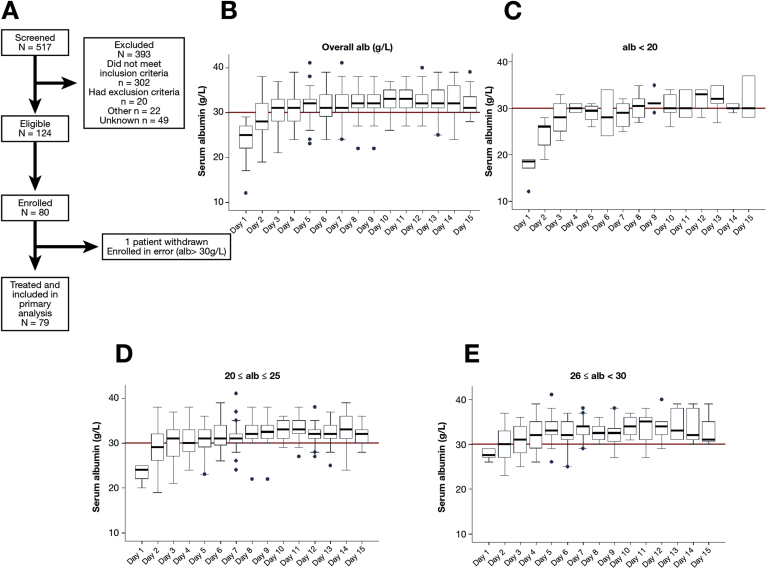
Targeted 20% HAS infusions according to the Albumin To PrevenT Infection In Chronic LiveR FailurE protocol effectively increase serum albumin to 30 g/L or greater. (A) Albumin To PrevenT Infection In Chronic LiveR FailurE feasibility study Consolidated Standards of Reporting Trials flowchart. (B) Median serum albumin levels throughout the study period. (C–E) Data are expressed according to baseline serum albumin (alb) level. Day 1 was defined as the time of recruitment (pretreatment). The horizontal line in the boxes indicates the median, the top and bottom of the box indicate the interquartile range; dots represent individual outliers, defined as data points greater than 1.5 times the interquartile range from the median.